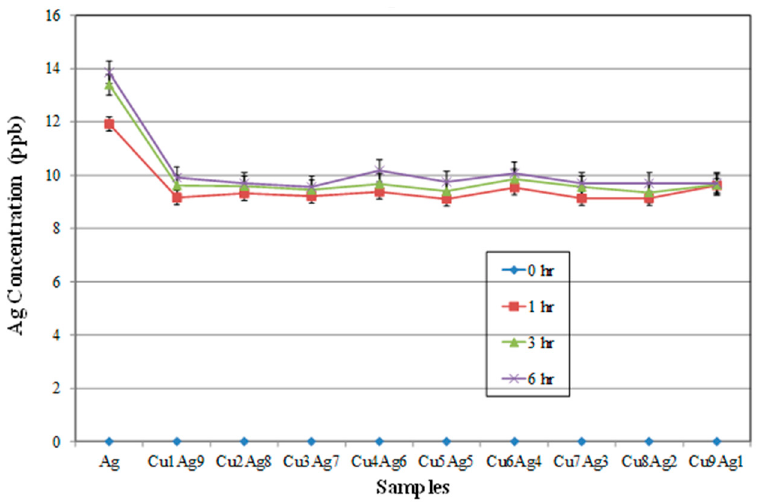
Figure 9. Ag + concentrations of Cu–Ag alloy films immersed in a buffer solution (pH = 7) as a function of time.